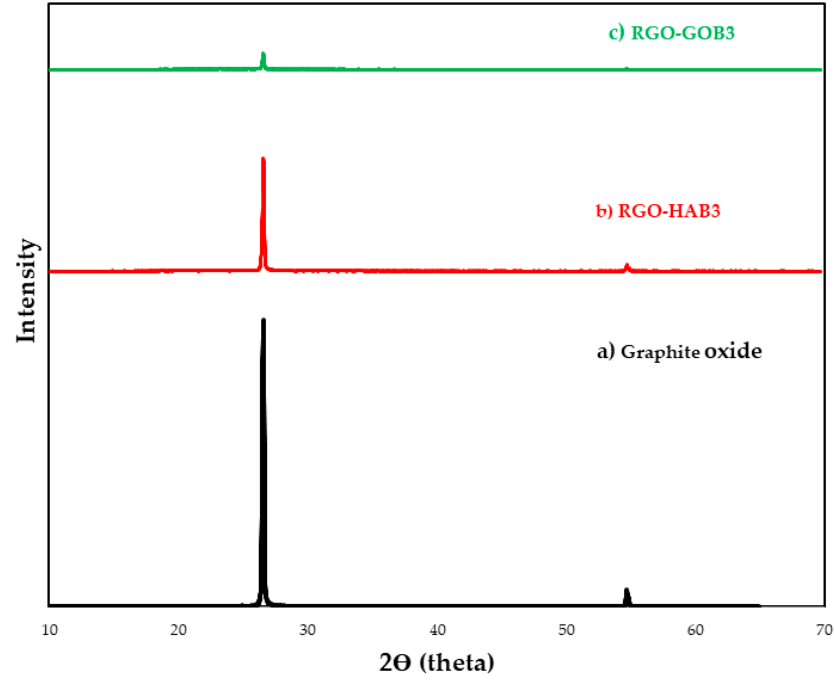
Figure 9. XRD diffraction patterns of graphene oxide (GO) and reduced graphene oxide (GRO) with natural extracts. (a) GO (unreduced), (b) HAB3 RGO-Capsicum 20%), and (c) GOB3 RGO-Larrea 20%).